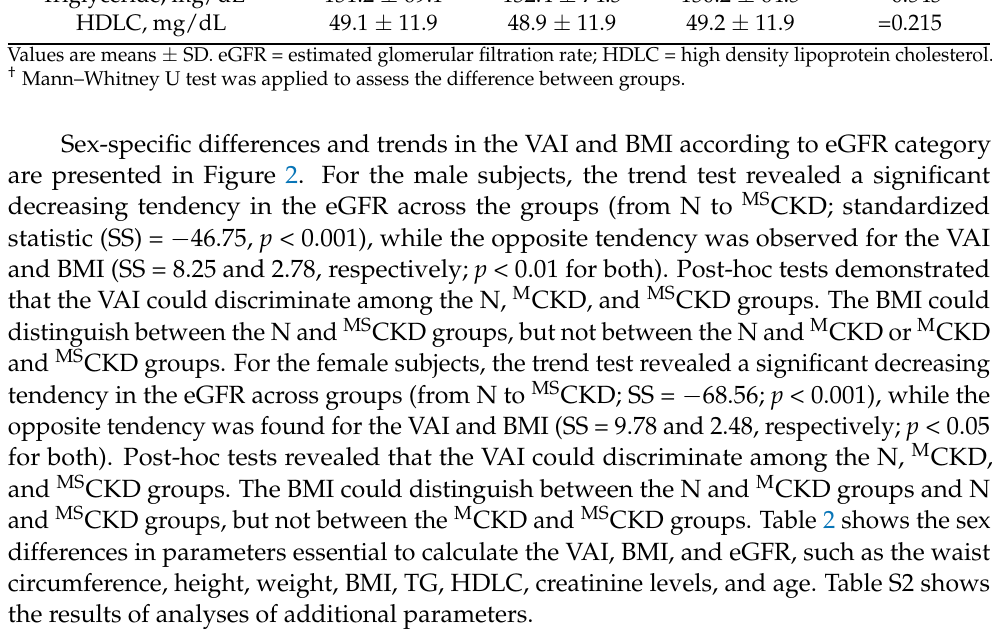
Table 1. The characteristics of study subjects and differences between males and females. Overall ( n = 7736) ( n = 3479)